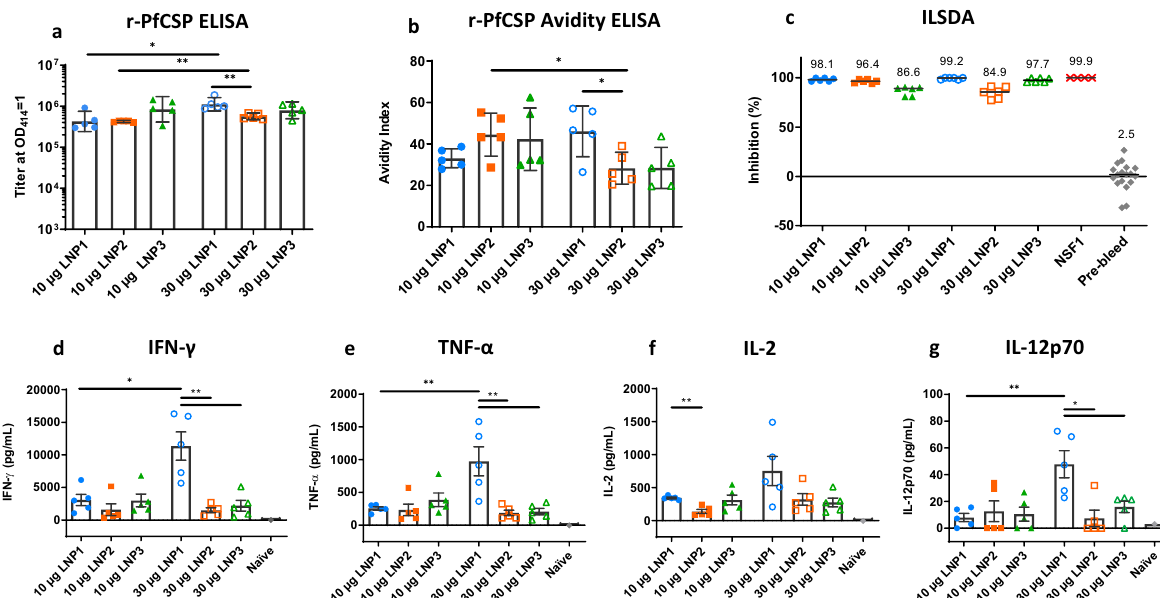
Fig. 1 PfCSP mRNA-LNP induce potent functional antibodies and cytokine responses. PfCSP mRNA (TriLink) was encapsulated in three different LNP formulations. BALB/c were injected with 10 µg and 30 µg dose of PfCSP mRNA-LNPs in a 3 week interval prime:boost regimen ( N = 5 per group). Serum and splenocytes were collected two weeks following the boost injection. a PfCSP antibody responses were determined by r-PfCSP titration ELISA and reported as the geometric mean (GM) with 95% con fi dence intervals (CI). b Avidity indices were calculated using a chaotrope-based avidity r-PfCSP titration ELISA and reported as the GM with 95% CI. c Functional activity of the antibodies was quanti fi ed by ILSDA using pooled mouse serum of each group. Inhibition was reported as the mean of assay replicates and calculated relative to the mean of sporozoite invasion in the absence of mouse serum. For d IFN- γ , e TNF- α , f IL-2, and g IL-12p70, splenocytes were incubated in the presence of a PfCSP overlapping 15-mer peptide pool. Cell culture supernatants were harvested after 48 h and cytokine concentrations quanti fi ed by MSD. Data are reported as the mean and standard error of the mean (SEM). All statistical analyses were performed using a Mann Whitney test (* p < 0.05; ** p <